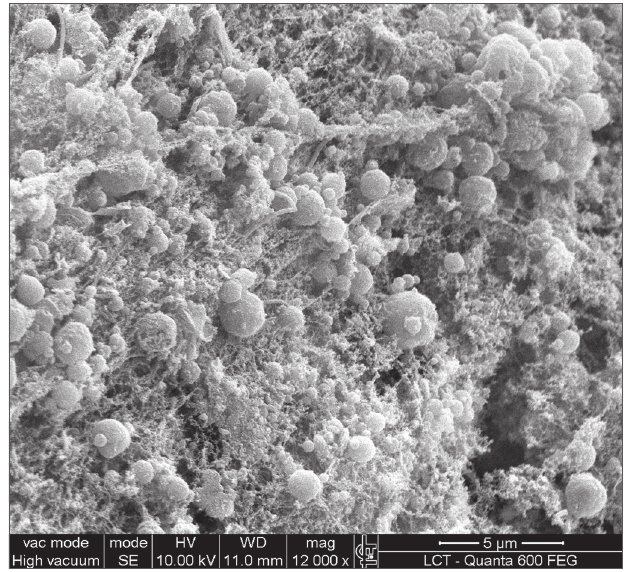
Figura 3. Biofilme bacteriano (aumento 12.000x)